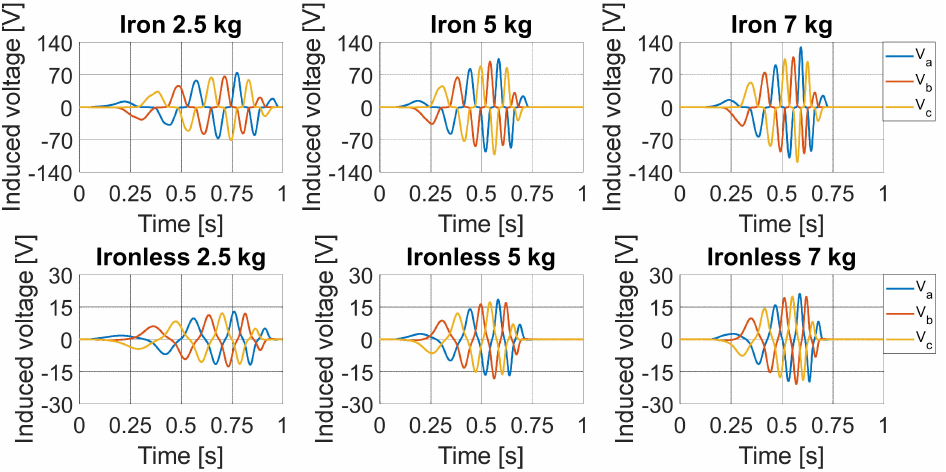
Figure 9. No-load voltage